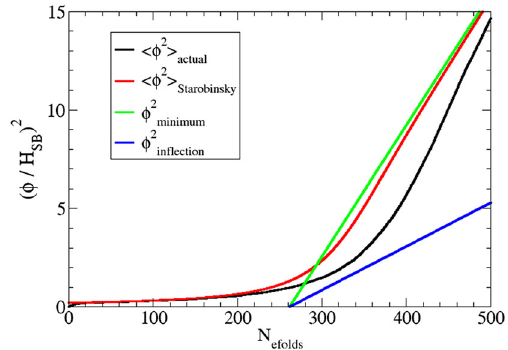
Fig. 4 Field dynamics with λ = 10 − 2 , N = 10 5 . 5 ,ϕ 0 = 10 − 1 . 41 M P and g =